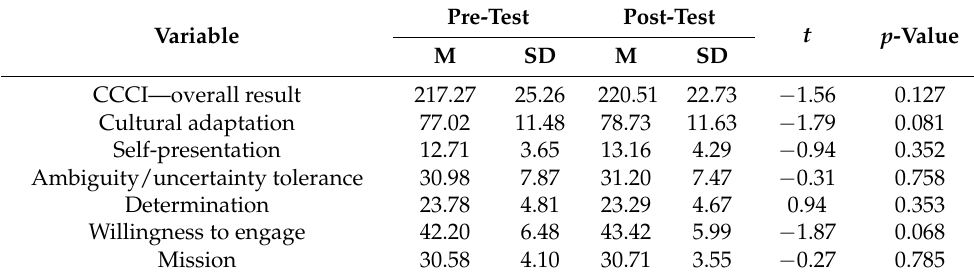
Table 2. Overall results of the Cross-Cultural Competence Inventory (CCCI) and subscales of nursing students in 2019 (study